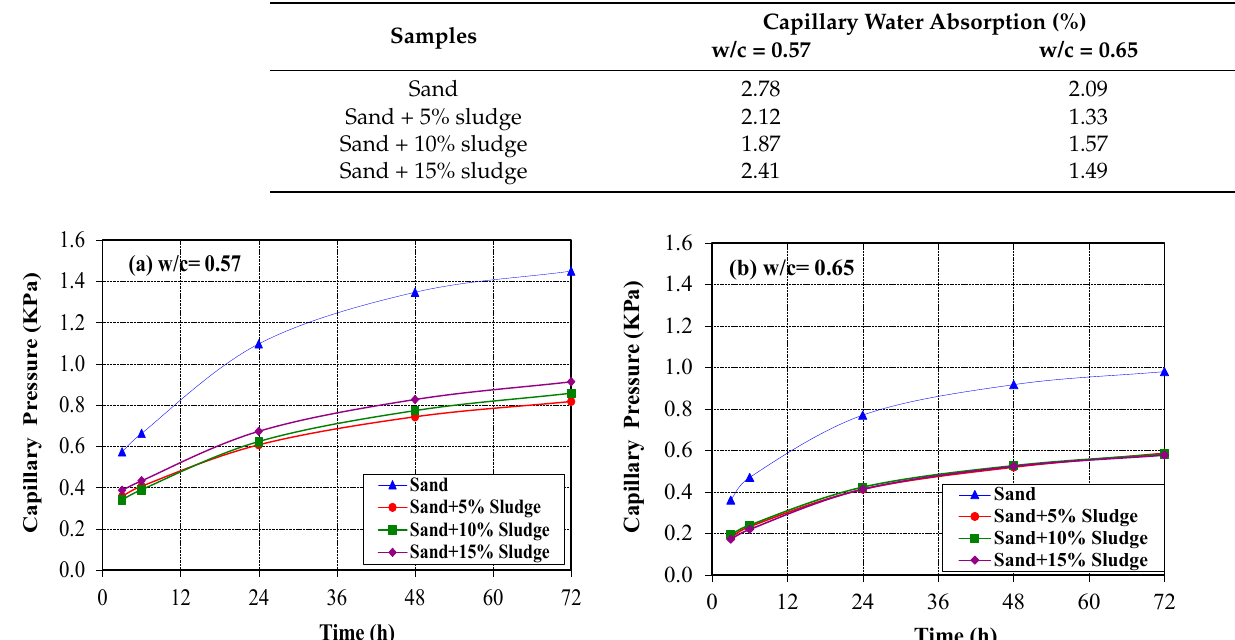
Table 3. Capillary absorption test result after 72 h.